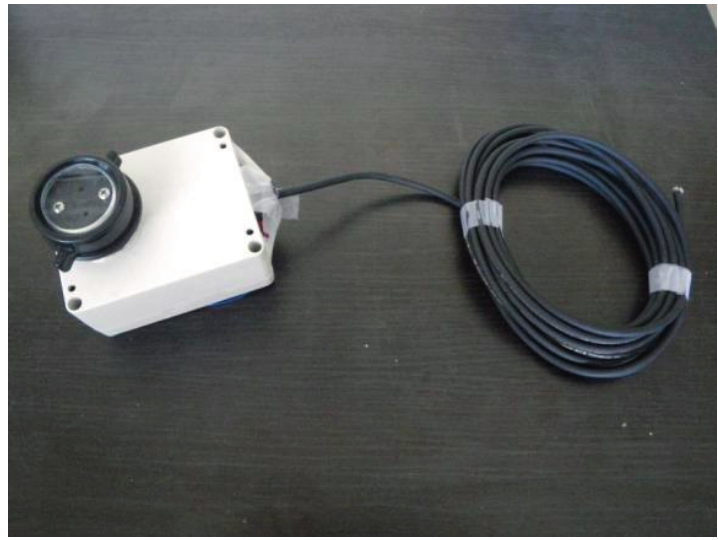
Figure 2. Sensor housing. A cable was used to power the instruments while a wireless link was used for communicating